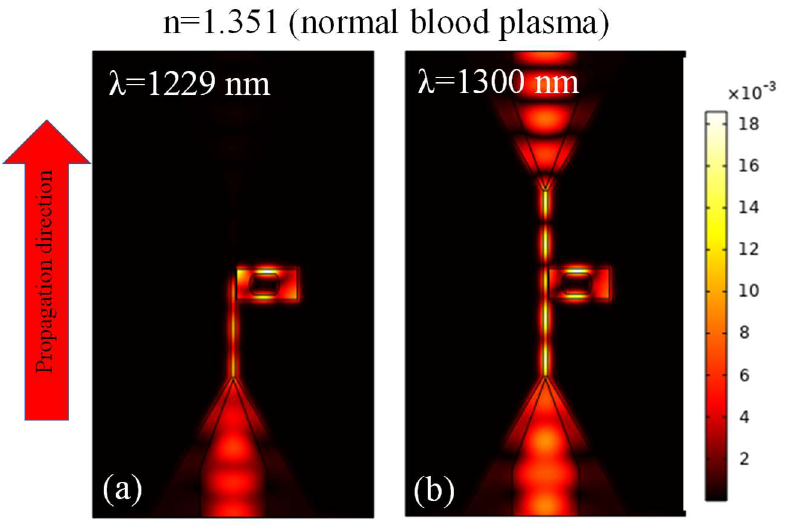
Figure 7. H-field distribution in the plasmonic sensor system at, ( a ) on-resonance state, ( b ) off-resonance state.